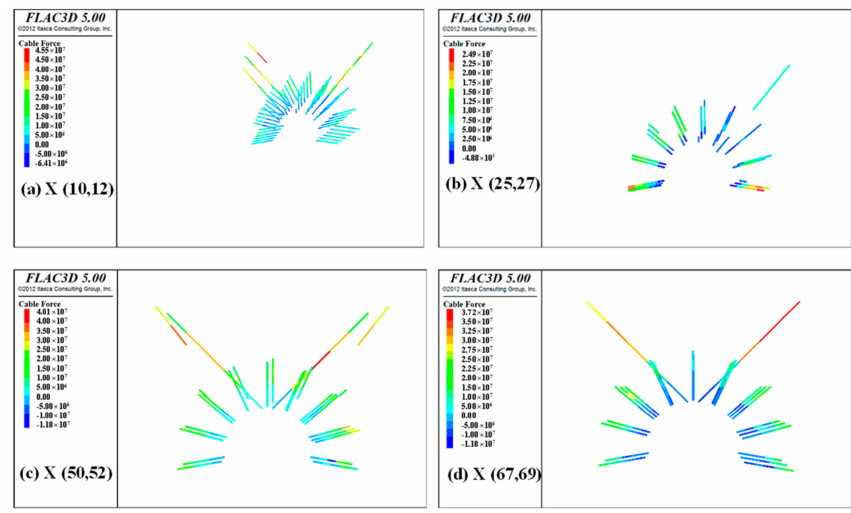
Figure 8. Cable force of the four monitoring areas without excavation disturbance.